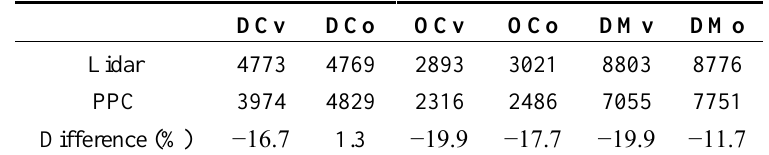
Table 6. Number of delineated trees based respectively on the lidar and PPC-based CHMs, and relative difference (PPC minus lidar) in